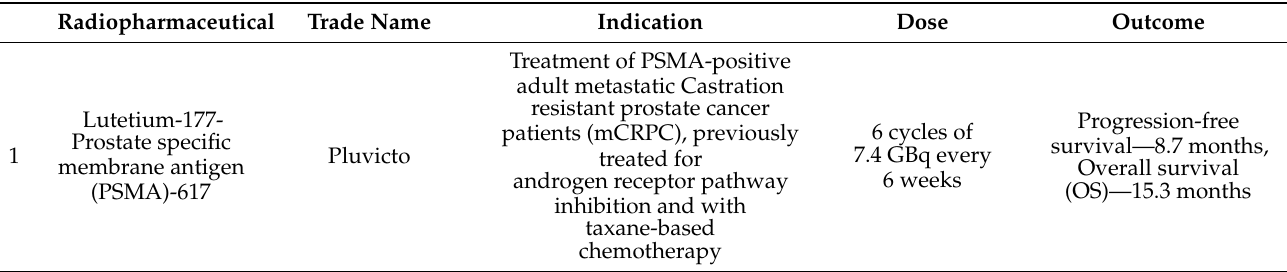
Table 2. Clinical utility and activity of therapeutic radiopharmaceuticals for prostate cancer and bone metastases